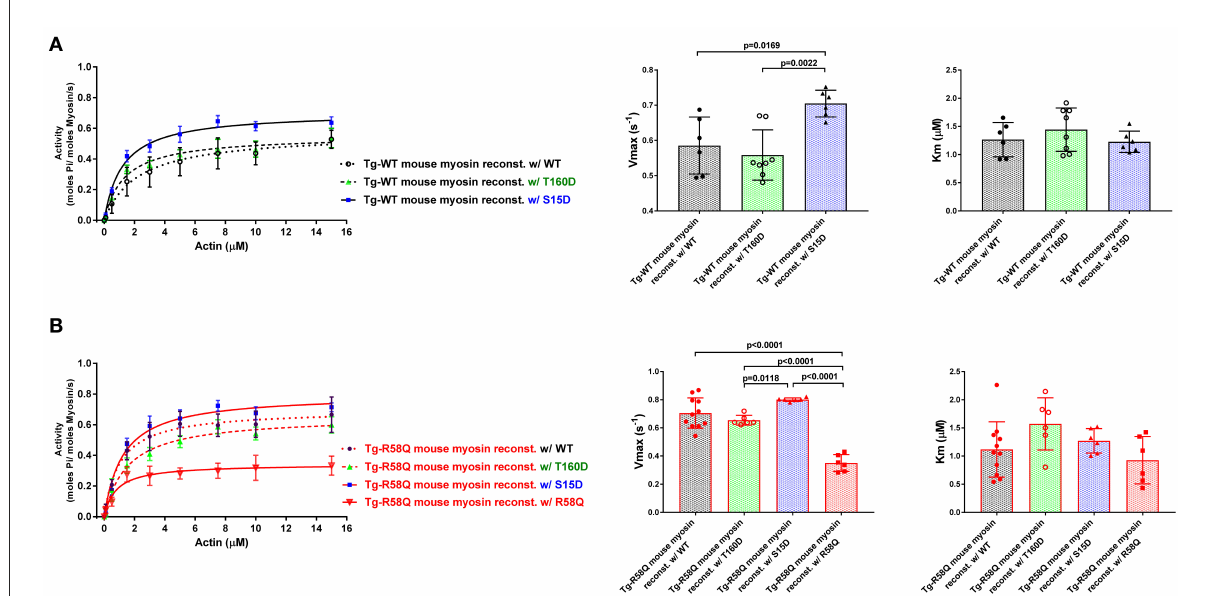
FIGURE3 Summary of the actin-activated myosin ATPase activity study. Titration isotherms (left panels), and V max (middle panels) and K m (right panels) parameters of Tg-WT (A) and Tg-R58Q (B) myosin reconstituted with recombinant WT-RLC (black), T160D (green), S15D (blue), and R58Q (red) proteins. Myosin (0.5 µ M) was complexed with actin of increasing concentrations (0–15 µ M), and the actin-activated ATPase activity was determined for all reconstituted myosin preparations. Data are expressed as mean ± SD of n = N ◦ experiments. For Tg-WT reconstituted w/WT-RLC, n = 6, w/T160D, n = 8, and w/S15D, n = 6. For Tg-R58Q reconstituted w/WT-RLC, n = 11, w/T160D, n = 6, w/S15D, n = 6, and w/R58Q, n = 6. Statistical significance between titration isotherms was calculated by two-way ANOVA with Tukey’s multiple comparisons, with